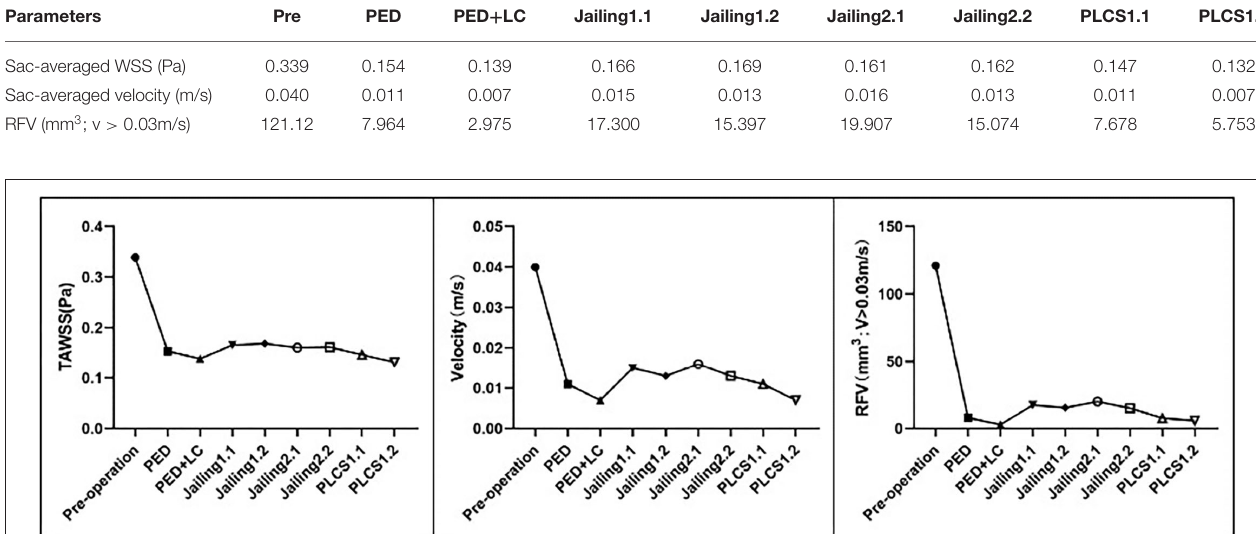
FIGURE 6 | Quantitative assessment of the sac-averaged WSS, sac-averaged velocity, and RFV of the simulated preoperative and various stent-assisted models.